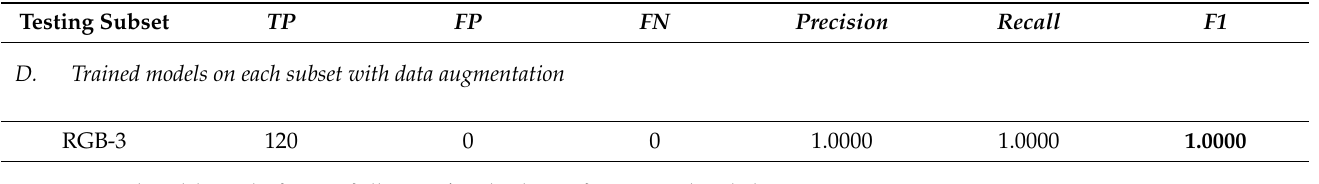
Table 4. Segmentation performance of Mask R-CNN models for the “Olive tree shadow” class applied to the four subsets of the OTCSS-dataset in terms of Precision , Recall and F1-measure. TP : True Positive; FP : False Positive; FN: False Negative. The testing datasets were: RGB-3 cm/pixel, RGB-13 cm/pixel, NDVI-13 cm/pixel, and GNDVI-13 cm/pixel. RGB: Red, Green, Blue; NDVI: normalized difference vegetation index; GNDVI: green normalized difference vegetation